Question: Summarize what this figure shows in one sentence.
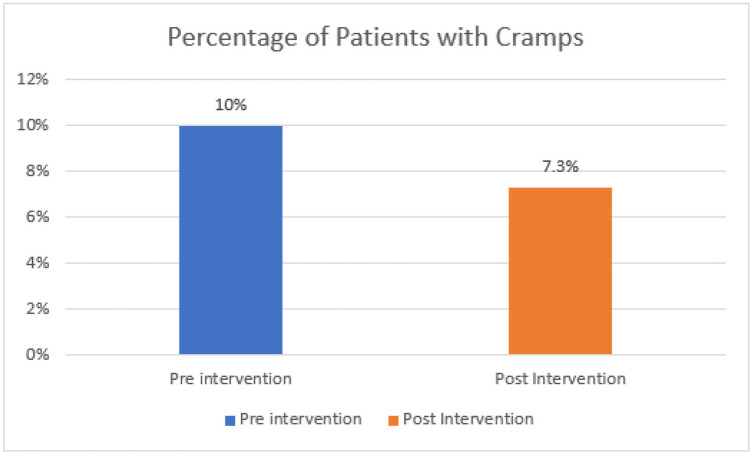
Answer: Percentage of patients experiencing cramps before and after the intervention.